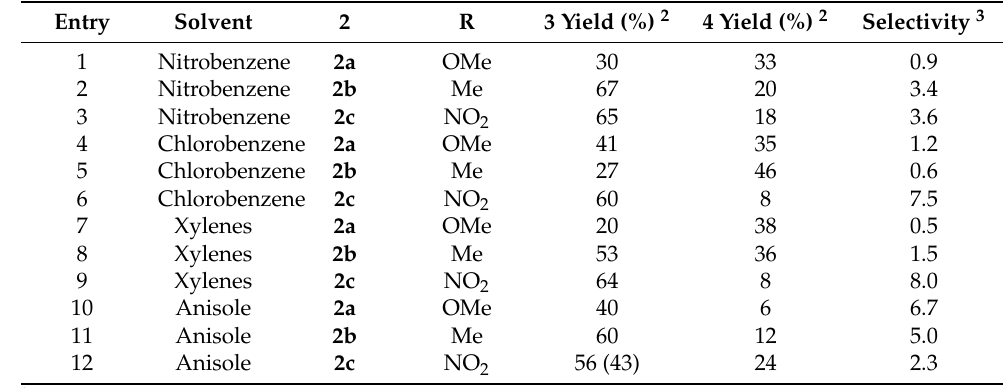
Table 1. Screening of aromatic solvents 1 .